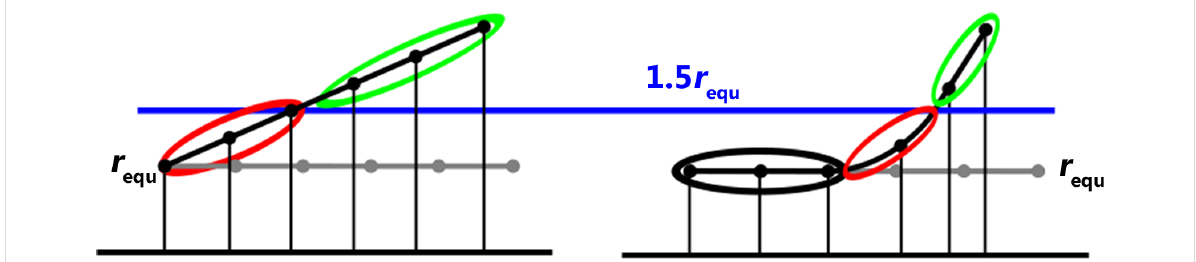
Figure 5: Demonstration of the contact zone and the reduced contact zone of an adsorbate/adsorbent complex with equilibrium distance r equ during separation in modes S2 and S3. Left: In separation mode S2, all atom pairs, except the one with the pivot atom, change their distance r IJ . Atom pairs with distances larger than the threshold value 1.5 r equ (adsorbate atoms encircled in green) do not contribute to the stabilization energy or to the adhe- sive forces. Non-zero contributions come from atom pairs in the reduced contact zone (adsorbate atoms encircled in red). Right: In separation mode S3, some part of the contact zone remains unchanged (adsorbate atoms encircled in black). These atom pairs contribute most to the stabilization energy, but not at all to the adhesive forces. The atom pairs with distances larger than the threshold value (adsorbate atoms encircled in green) do not contribute to the stabilization. Atom pairs in the reduced contact zone (adsorbate atoms encircled in red) contribute less to the stabilization energy than atom pairs from the (black) contact zone but they are the origin of the change in the adhesive